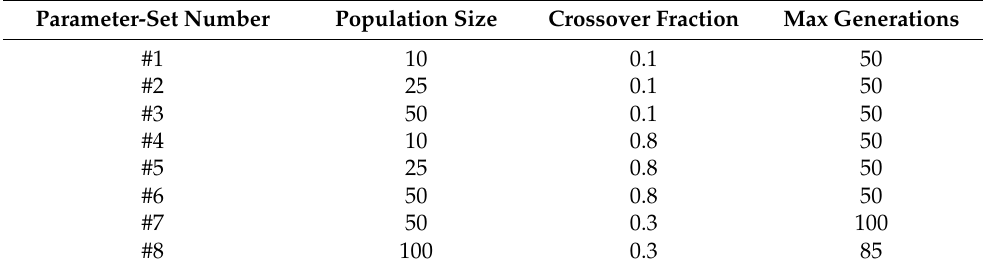
Figure 7. Performance of the proposed neural networks. Table 4. GA Parameters.